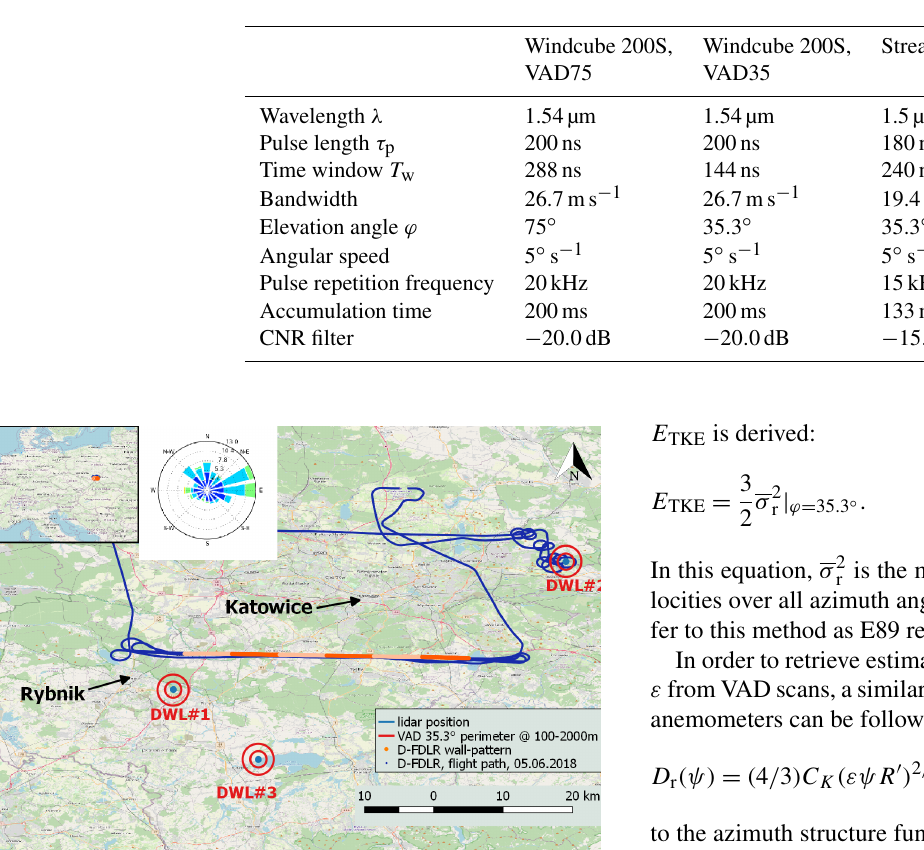
Table 1. Main technical specifications of the Doppler wind lidars.